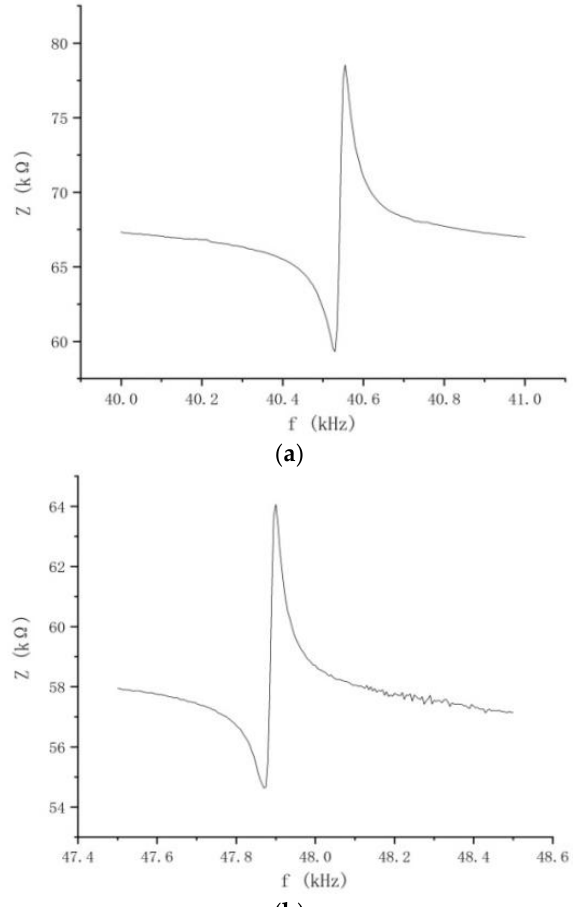
Figure 12. The effect of pre-pressure on frequency. ( a ) Impedance diagram when the pre-pressure is 0 N. ( b ) Impedance diagram when the preload is 500 N.